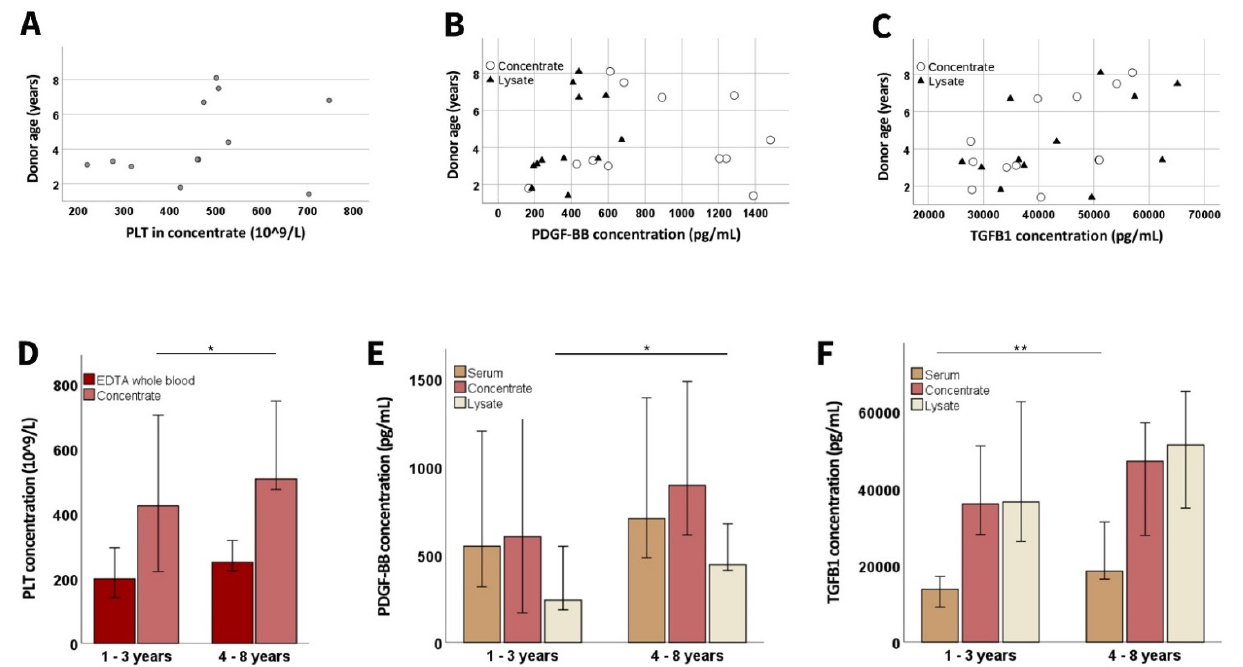
Figure 3. Age-related differences in platelet and growth factor concentrations. The dot plots show donor age vs. platelet (PLT; ( A )) concentration in concentrate, as well as platelet-derived growth factor (PDGF-BB; ( B )) and transforming growth factor (TGFB1; ( C )) concentrations in concentrate (circles) and lysate (triangles); the correlation shown in ( B ) was significant for lysate ( p < 0.001 and r = 0.820, based on Spearman’s rank correlation). The bar plots show the median PLT ( D ), PDGF-BB ( E ), and TGFB1 ( F ) concentrations in EDTA whole blood or serum samples drawn directly from the donor dogs, as well as in samples from different processing stages, obtained from younger and older donors; data from the younger vs. the older animals were compared using Mann–Whitney U tests; the asterisks indicate the significant differences between the corresponding groups (* corresponds to p < 0.05; ** corresponds to p < 0.01). Data were obtained from n = 7 younger and n = 5 older